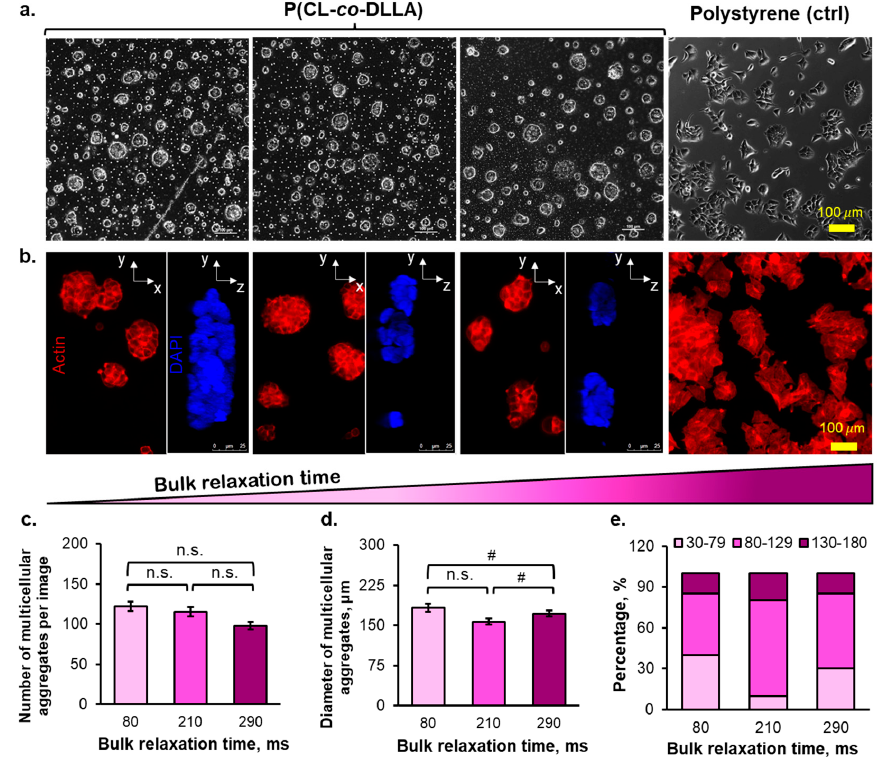
Figure 2. ( a ) The brightfield image (x–y) of the morphology of the multicellular aggregates of MCF-7 on day 5, ( b ) The actin (red) stained and z-axis view of DAPI (blue) stained- cells on day 5, ( c ) the number of generated multicellular aggregates on day 5, ( d ) the average diameter of the multicellular aggregates on day 5, and ( e ) the diameter distribution frequency of the multicellular aggregates on day 5. (Statistical analyses: Student’s t -test n.s. p > 0.05; # p < 0.05).